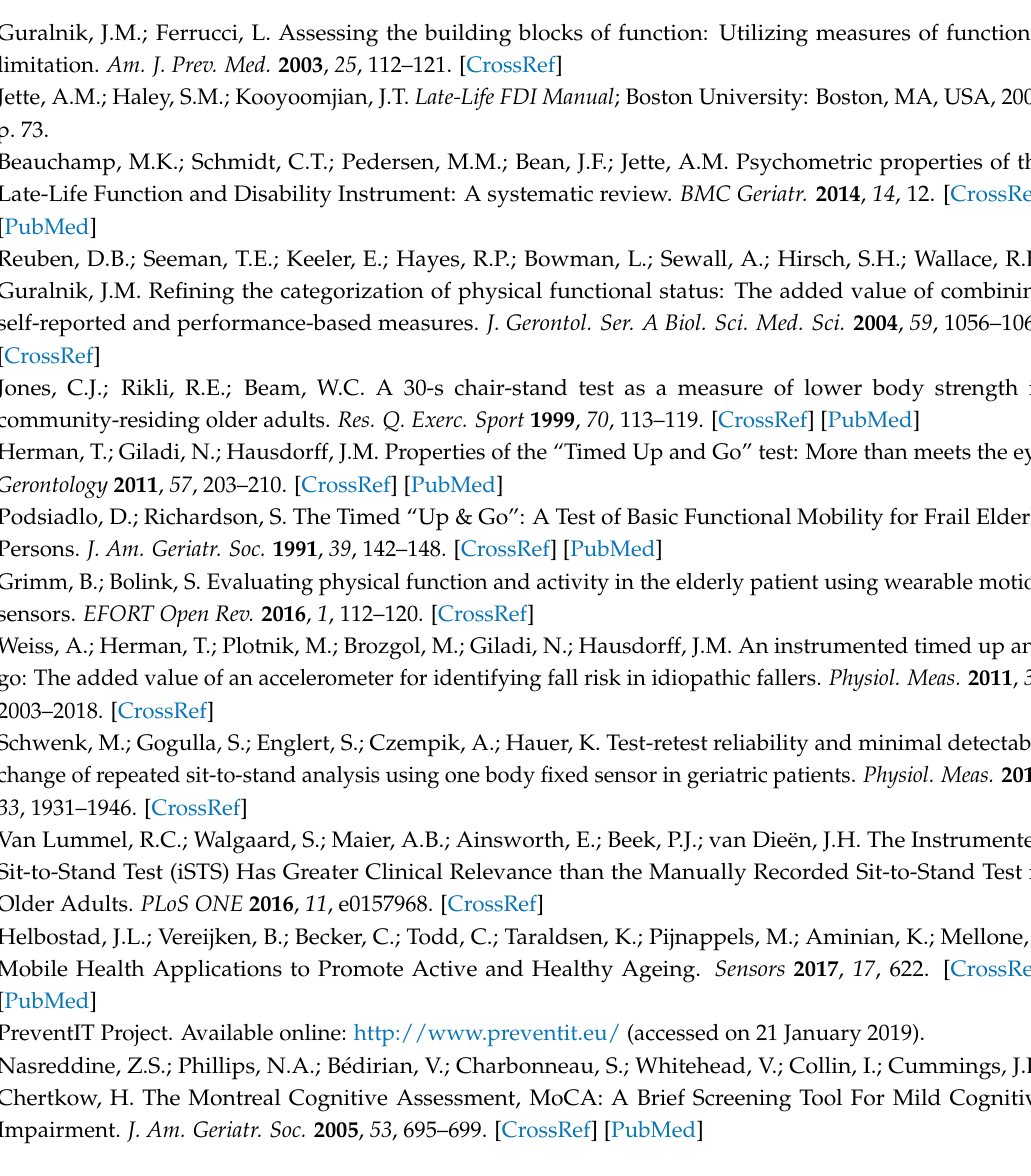
and multivariable analysis of the 30CST instrumented physical performance measures; Table S3: Collinearity analysis of the TUG instrumented physical performance measures; Table S4: Univariable and multivariable analysis of the TUG instrumented physical performance measures; Table S5: Bootstrapping validation of the 30CST and TUG